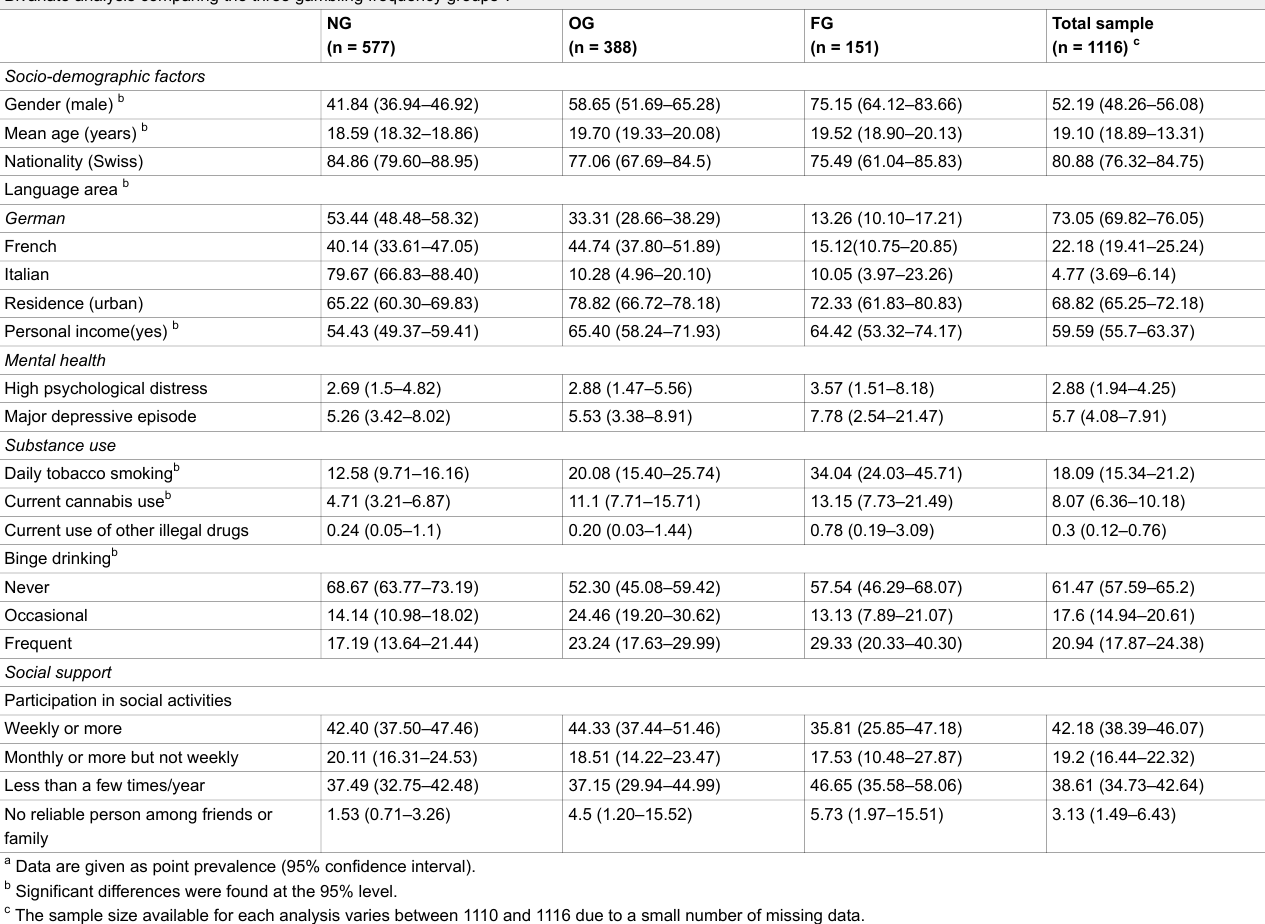
Table 1 Bivariate analysis comparing the three gambling frequency groups a